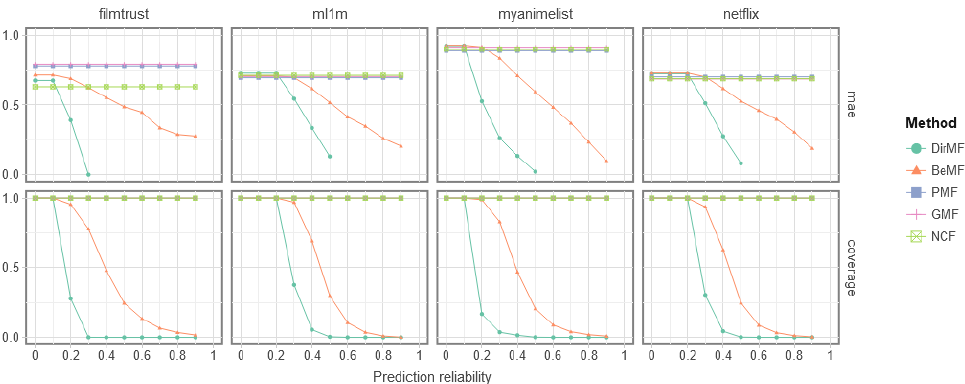
Figure 2. Quality of the predictions measured by MAE and coverage. Predictions with lower reliability than those indicated on the x -axis are filtered